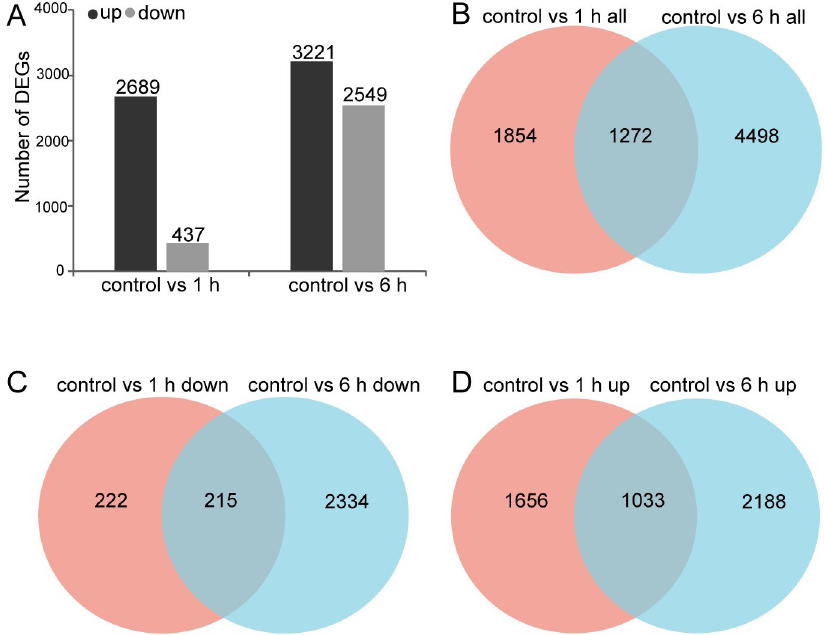
Fig 1. Comparative statistics of differentially expressed genes (DEGs) in MeJA-treated C . wenyujin . (A) Total number of up-regulated and down regulated genes in different groups (group 1: control vs 1 h; group 2: control vs 6 h). (B-D) Venn diagram illustrating the shared and unique DEGs between different groups. The overlaps indicate the number of shared DEGs between different groups.